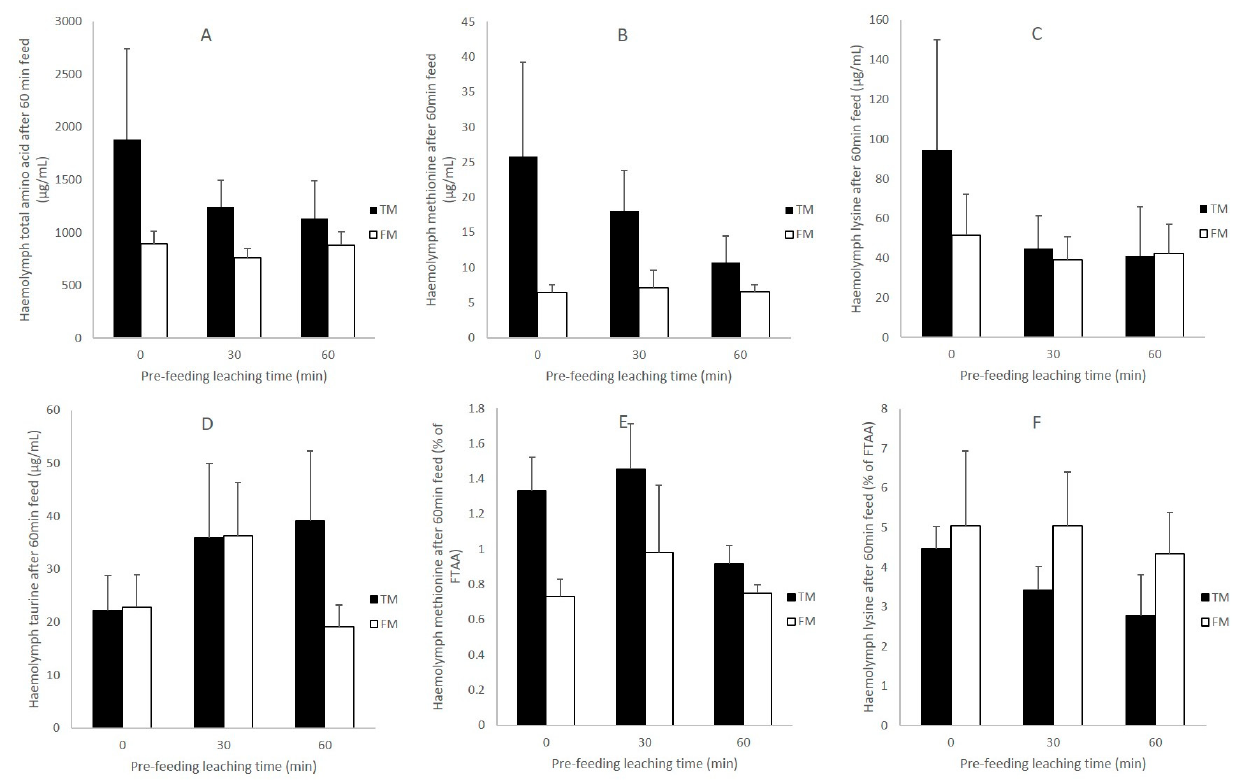
Figure 6. Haemolymph amino acid ( µ g mL − 1 ) in shrimp fed for 60 min on diets that had been previously leached for 0 (fresh), 30 min and 60 min. ( A ) Free total amino acid (TAA); ( B ) free methionine; ( C ) free lysine; ( D ) taurine; ( E ) free methionine in proportion to TAA (%); ( F ) free lysine in proportion to TAA (%). Note, all shrimp were given the same ration in terms of percentage body weight (1% BW).